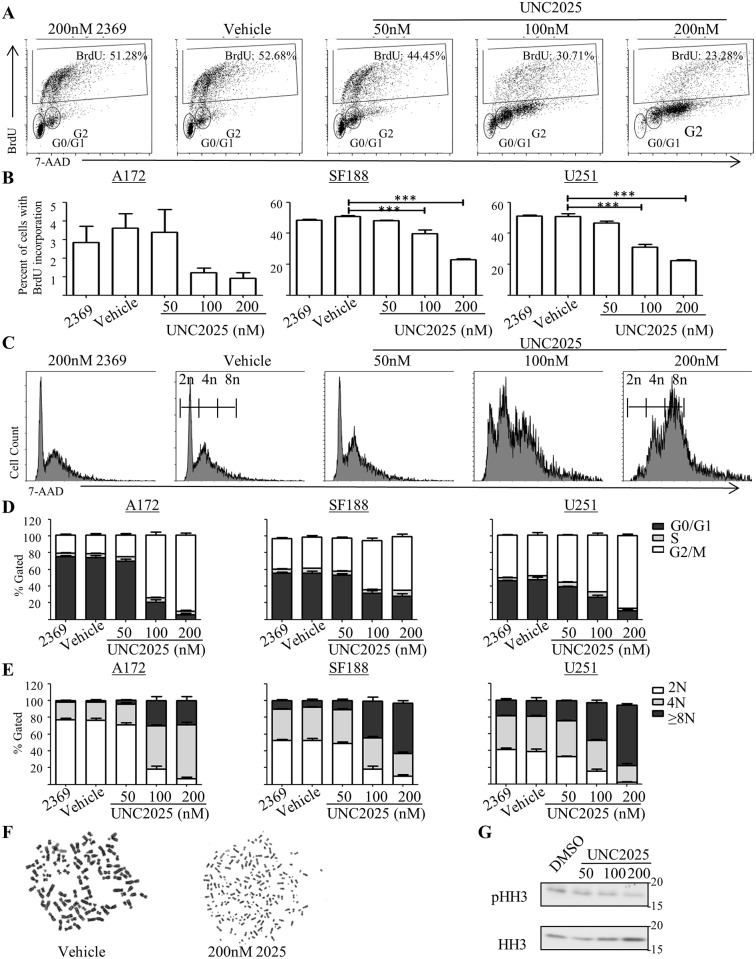
UNC2025 inhibits proliferation and induces polyploidy in GBM cells.A172, SF188, and U251 cells were treated with the indicated concentrations of UNC2025, 200nM UNC2369 (a negative control TKI), or vehicle (DMSO) for 48 hours. (A-C) BrdU was added to the culture medium four hours prior to harvest and cells were fixed, and stained with a fluorescent anti-BrdU antibody and propidium iodide, prior to analysis by flow cytometry. (A) Representative flow cytometry plots showing BrdU incorporation in the U251 cell line. (B) Quantitation of BrdU incorporation. Mean values and standard errors derived from 3 independent experiments are shown. (C) Representative flow cytometry plots showing propidium iodide staining as an indicator of DNA content in the U251 cell line. (D-E) Cells were permeabilized and stained with propidium iodide prior to analysis by flow cytometry. (D) Quantitation of DNA content. Mean values and standard errors derived from four independent experiments are shown. (E) Cell cycle distribution in cells with <8N DNA content. Mean values and standard errors derived from four independent experiments are shown. (F) Metaphase spreads were prepared from U251 cells to determine ploidy. Representative images are shown. (G) Cell lysates were prepared from U251 cells and phosphorylated and total histone H3 (HH3) were detected by immunoblot A representative image from three independent experiments is shown. (* p<0.5, ** p<0.01, *** p<0.001, 1-sided ANOVA).